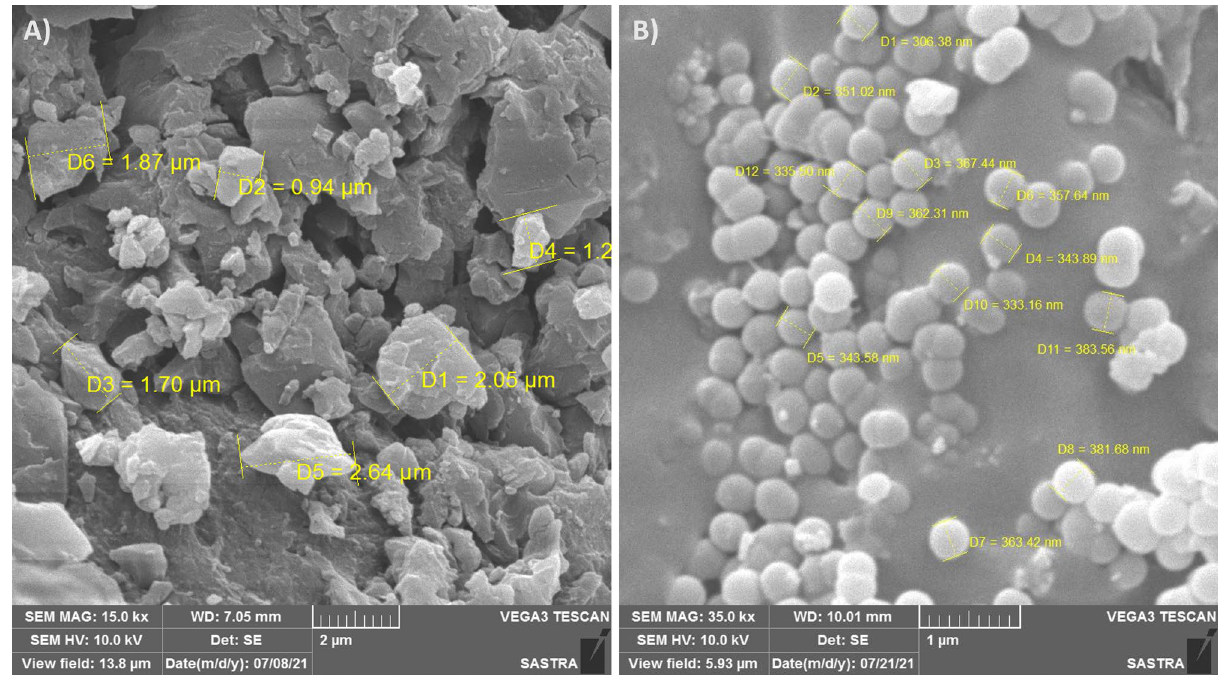
Figure 1. Scanning electron microscopy images showing ( A ) irregular flakes-like structures of pure sample of 2-methoxy-4-vinylphenol (2M4VP) at 15.0 kx magnification, ( B ) uniform spherical-shaped cellulose acetate phthalate nano-formulation of 2M4VP (CAP-2M4VP) at 35.0 kx